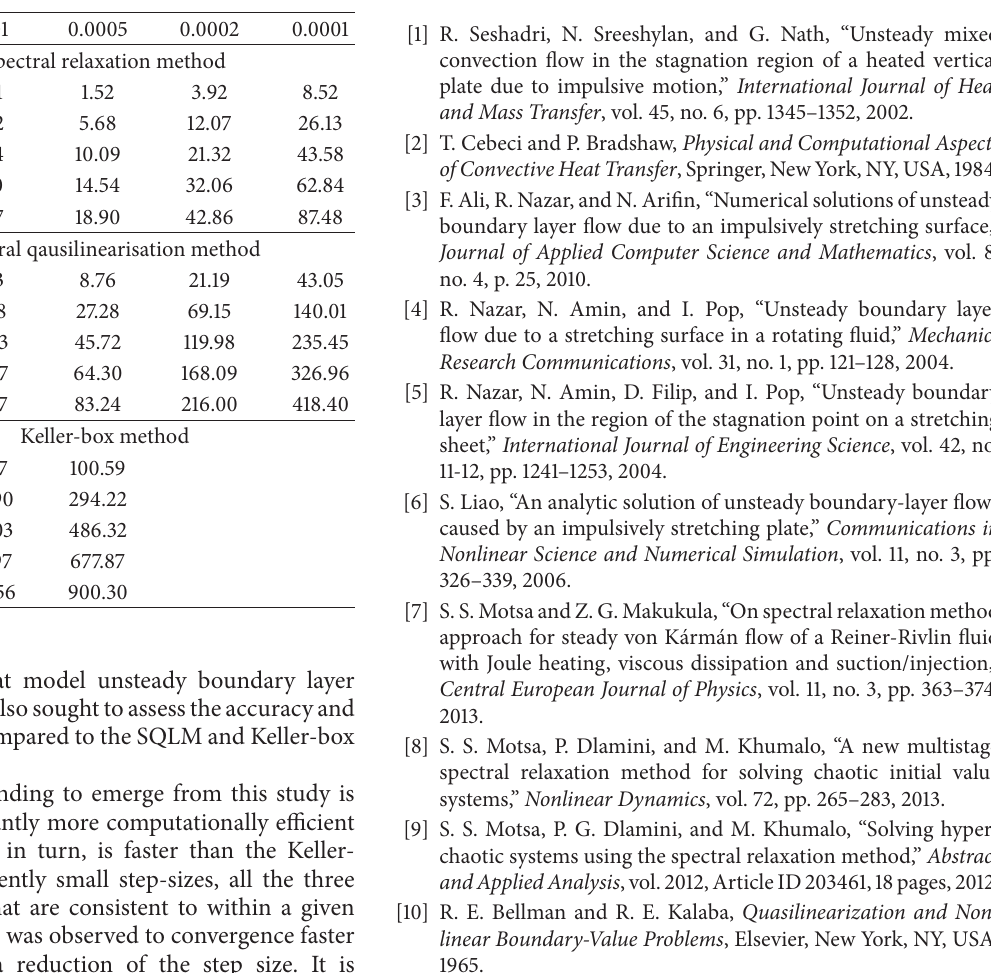
Figure 4: Variation of the SQLM iterations with time 𝜉 in Example 2. Table 6: SRM and SQLM computational times for Example